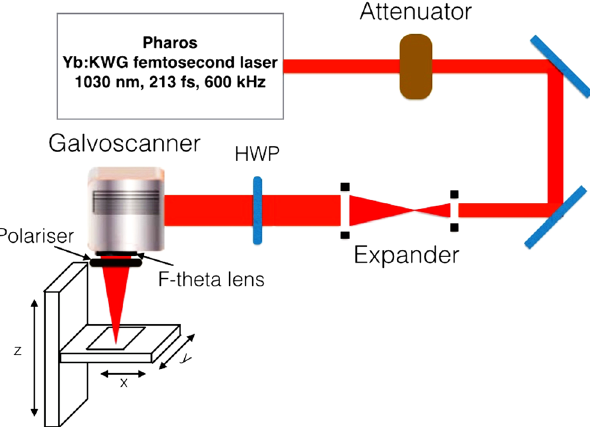
Figure 5. Scheme of the experimental setup used for irradiation of metallic samples. HWP: Half-wave plate.